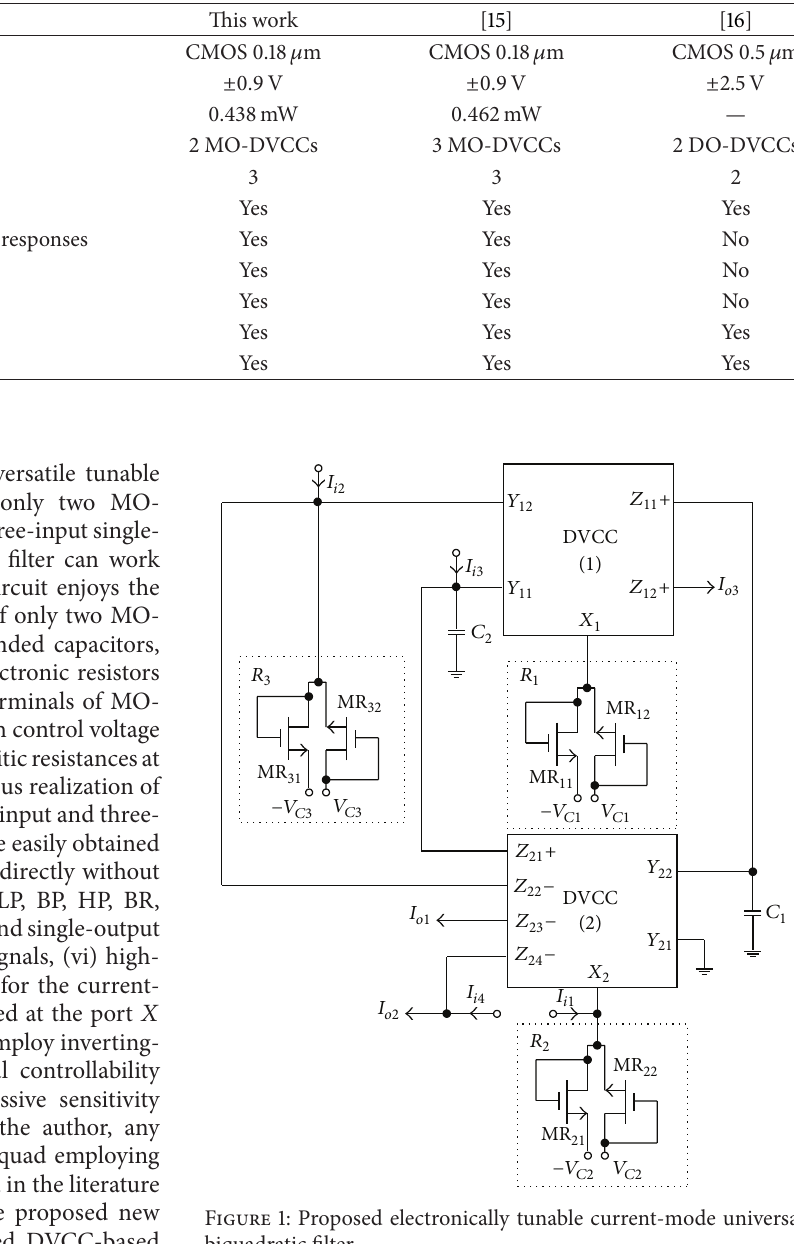
Table 1: Comparison with recently reported of DVCC-based current-mode universal function filters.